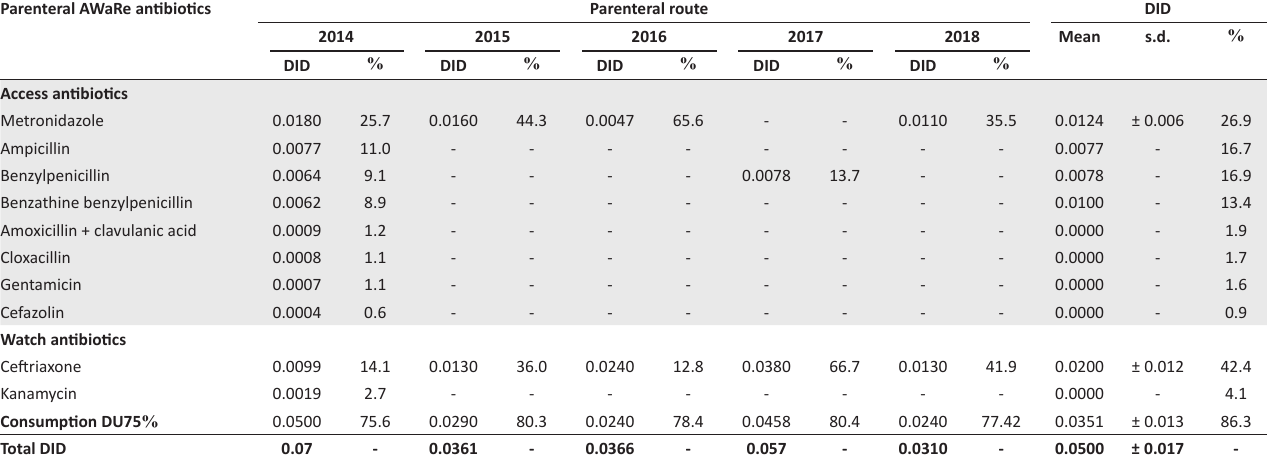
TABLE 5: Commonly consumed antibiotic at Anatomical Therapeutic Chemical classification system level 5 by absolute and relative parenteral route (drug utilisation 75 % ) and Access, Watch and Reserve classification. Parenteral AWaRe antibiotics Parenteral route